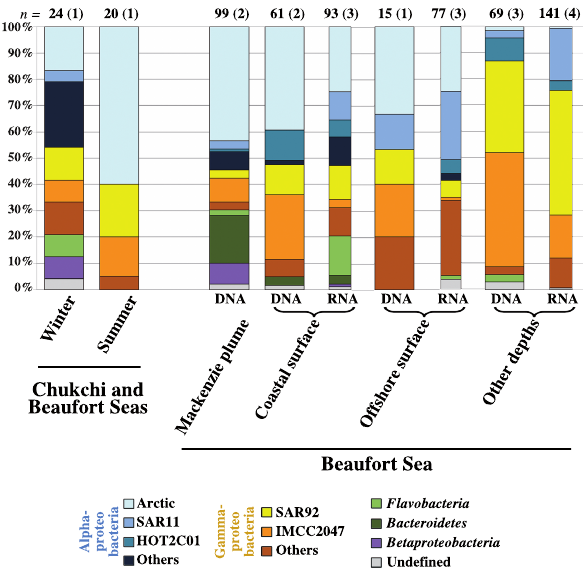
Figure 5. Relative abundance of PR genes in clone libraries ob- tained from Arctic Ocean samples. Clones were retrieved from coastal samples of the Chukchi and Beaufort seas in summer and winter (Cottrell and Kirchman, 2009) and from the Mackenzie plume, coastal and offshore surface waters and other depths (Boeuf, 2013). The numbers of clones and libraries analyzed are indicated in bold and between brackets,